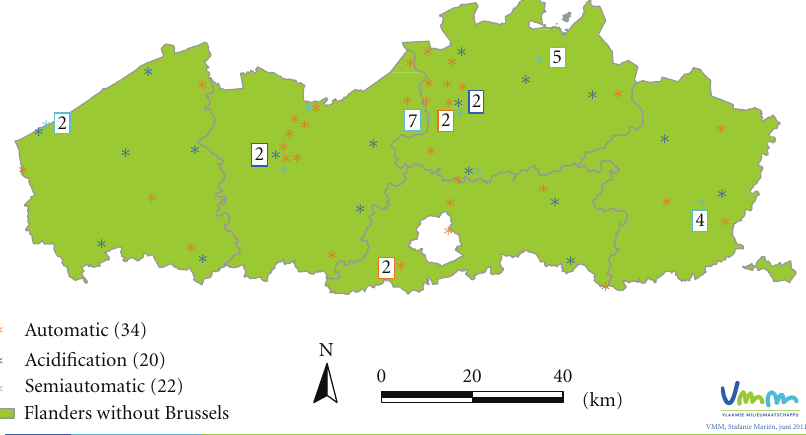
FIGURE 2: Map of Flanders, with the spread of monitoring stations for automatic and semiautomatic